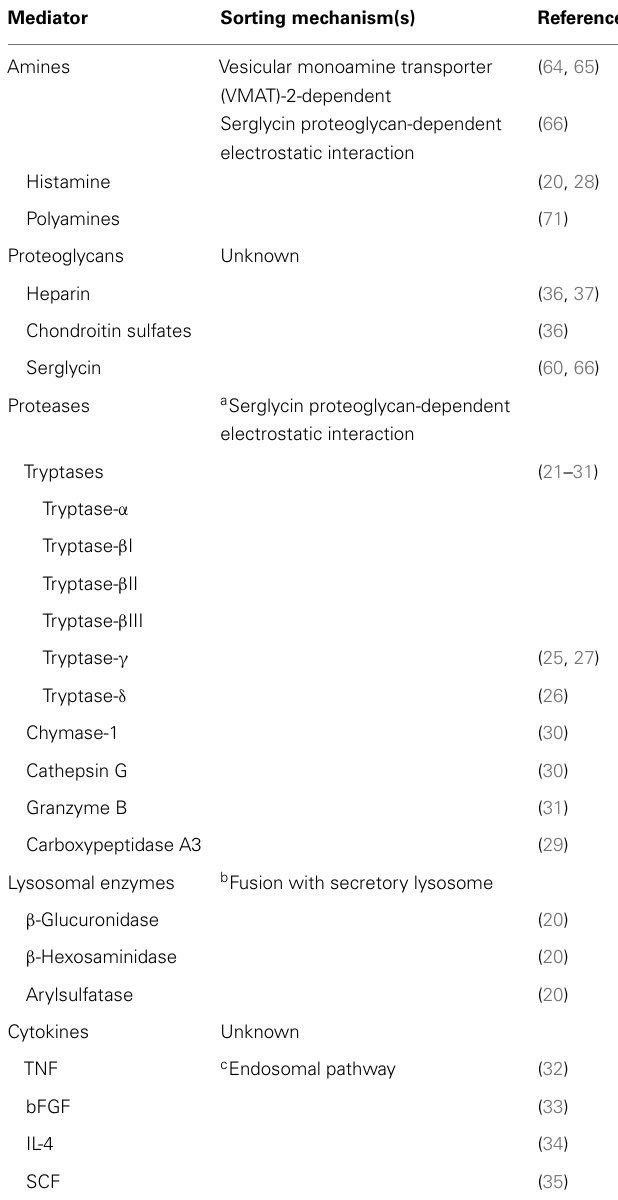
Table 1 | Mediators stored in human mast cell granules and their sorting mechanisms